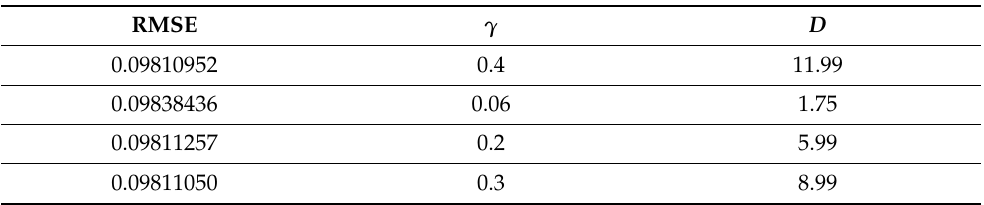
Table 1. Illustrative values of RMSE, with the global minimum highlighted in bold print obtained by means of conjugated gradient algorithm.